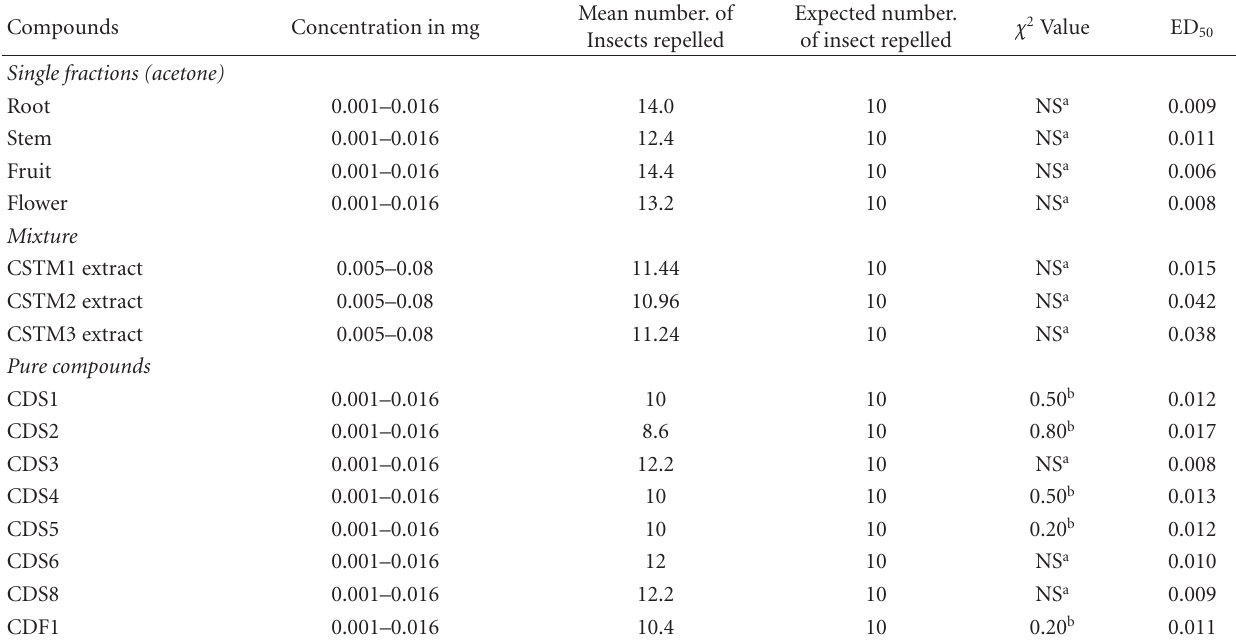
Table 2: Percent repellency obtained in solvent extracts and pure compounds isolated from Capparis decidua against Indian white termite Odontotermes